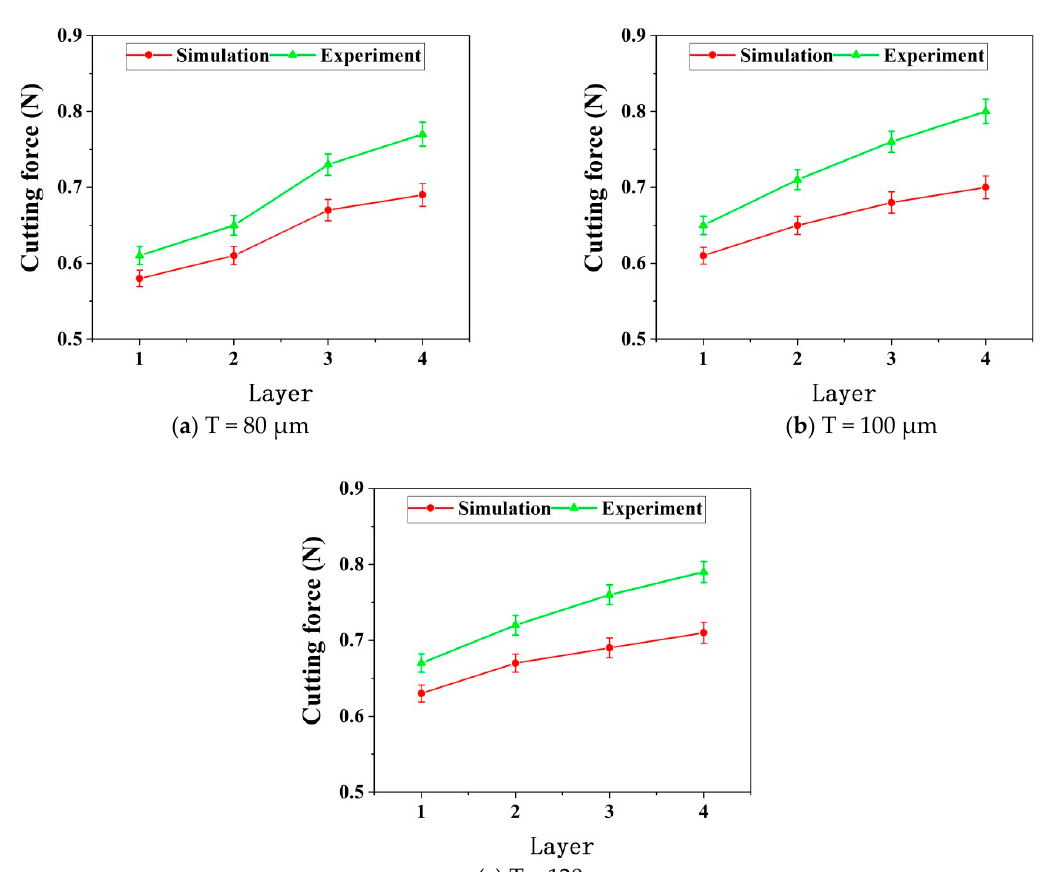
Figure 13. Cutting forces without radial cutting parameter compensation.